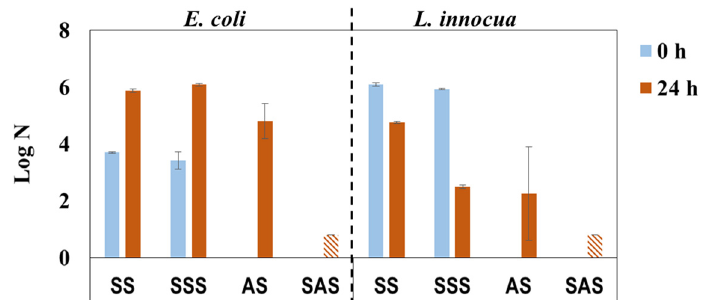
Figure 6. Antimicrobial activity of PHMB ‐ HPLs prepared with two different approaches, against E. coli and L. innocua just after inoculation (0 h) and after incubation for 24 h (SS and SSS are the control samples for AS and SAS, respectively; , Below detection limit).